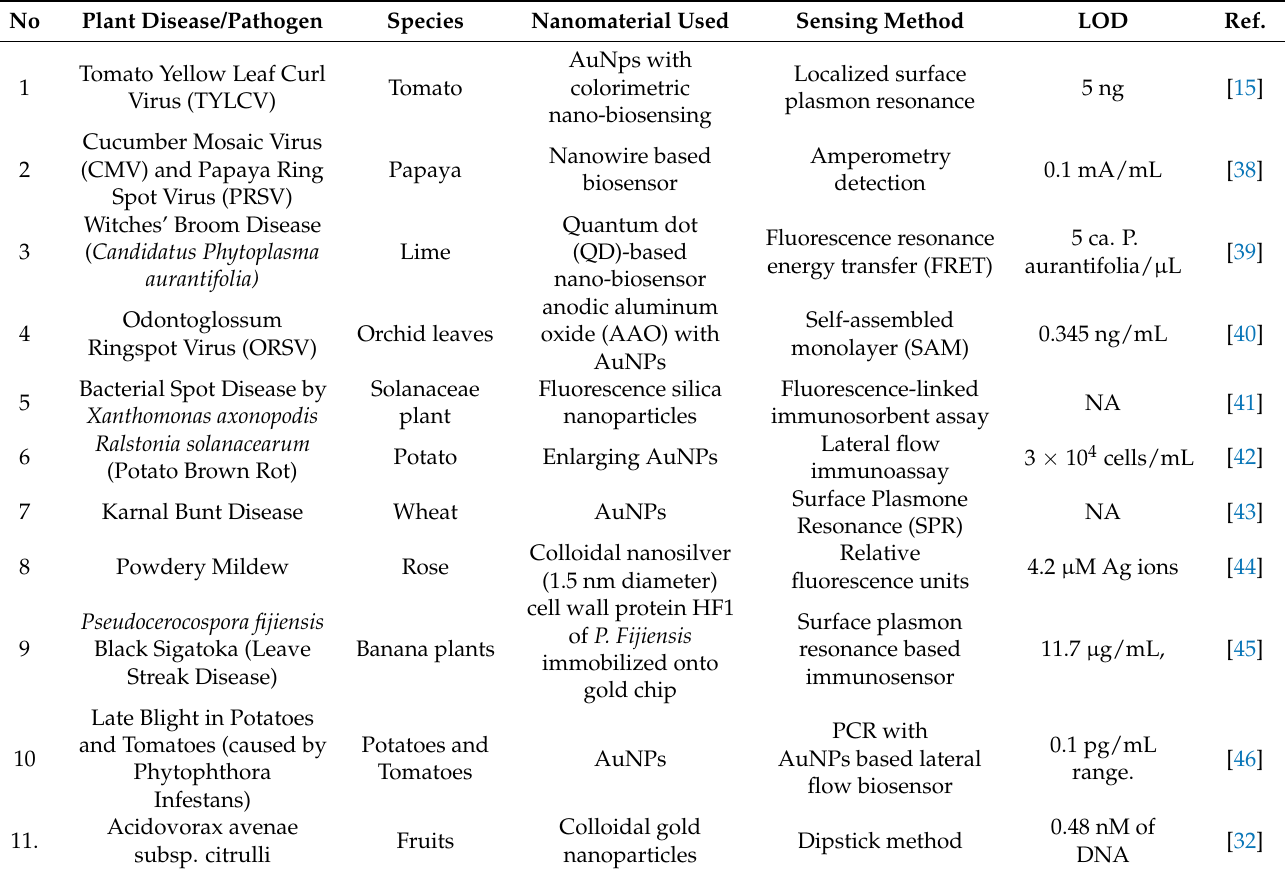
Table 2. Different sensing approaches and nanomaterial used for plant pathogen